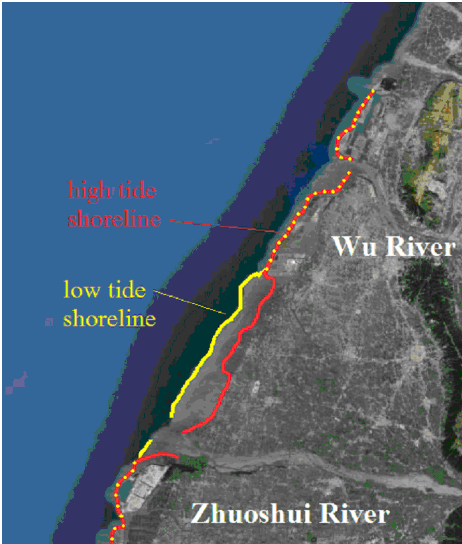
Figure 12. Model domain for numerical simulations with STRiPE. Also shown are the shorelines for low tide (yellow) and high tide (red) conditions. The area between the red and the yellow contours is the WAD